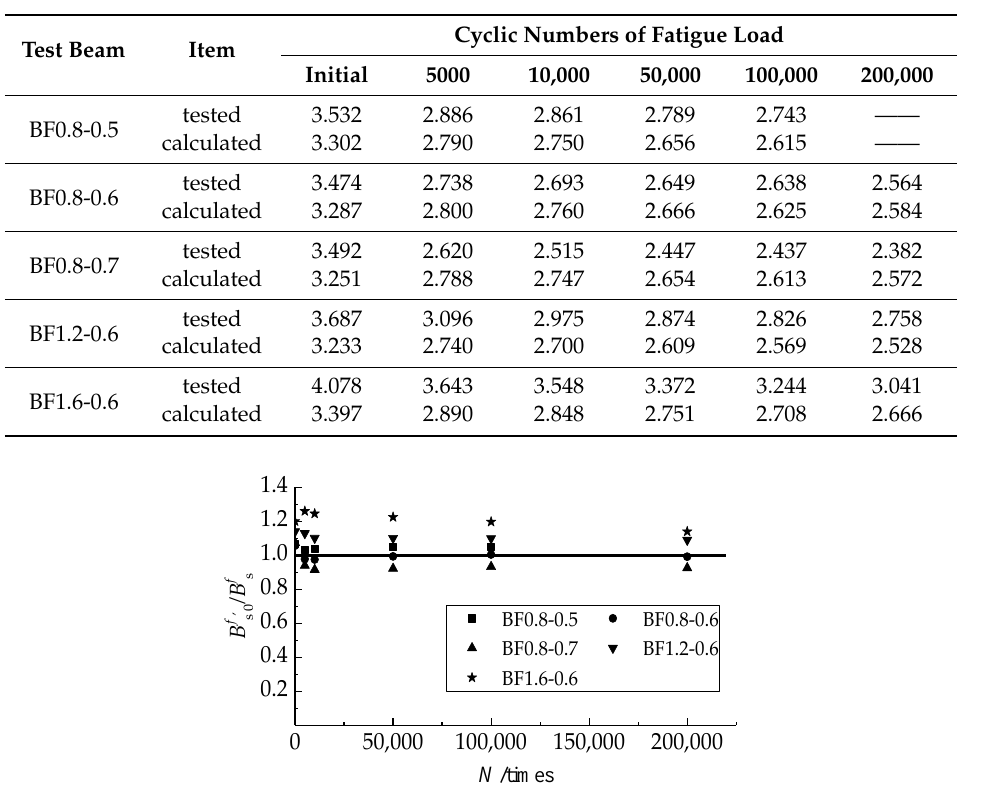
Table 6. Comparison between measured and calculated values of fatigue sti ff ness.